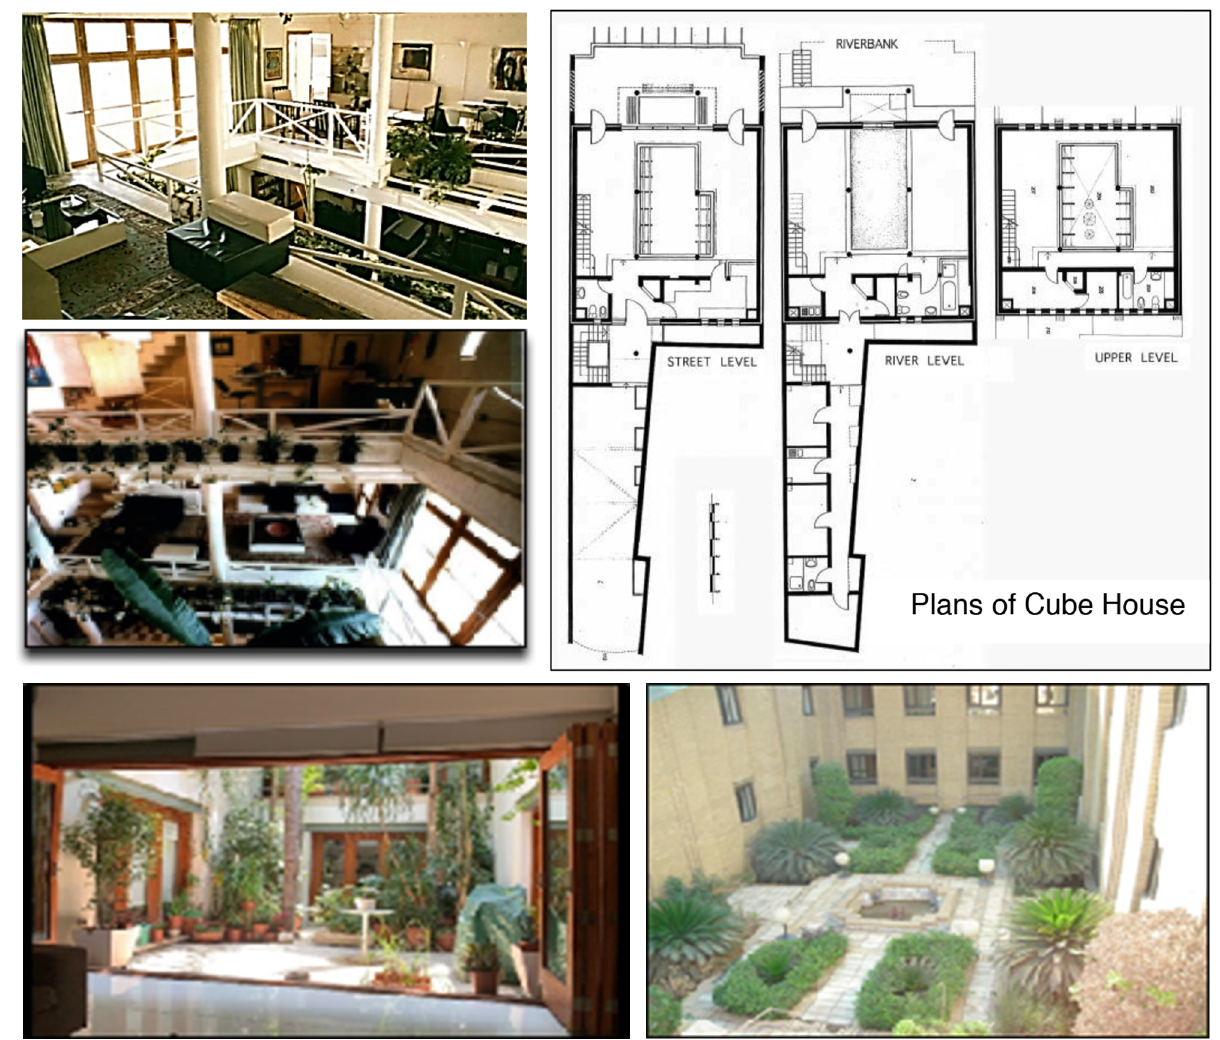
Fig. 8. A cube house in Baghdad, Iraq (above). A hospital and a private house (bottom). Source: Design by Maath Alousi from the Architect